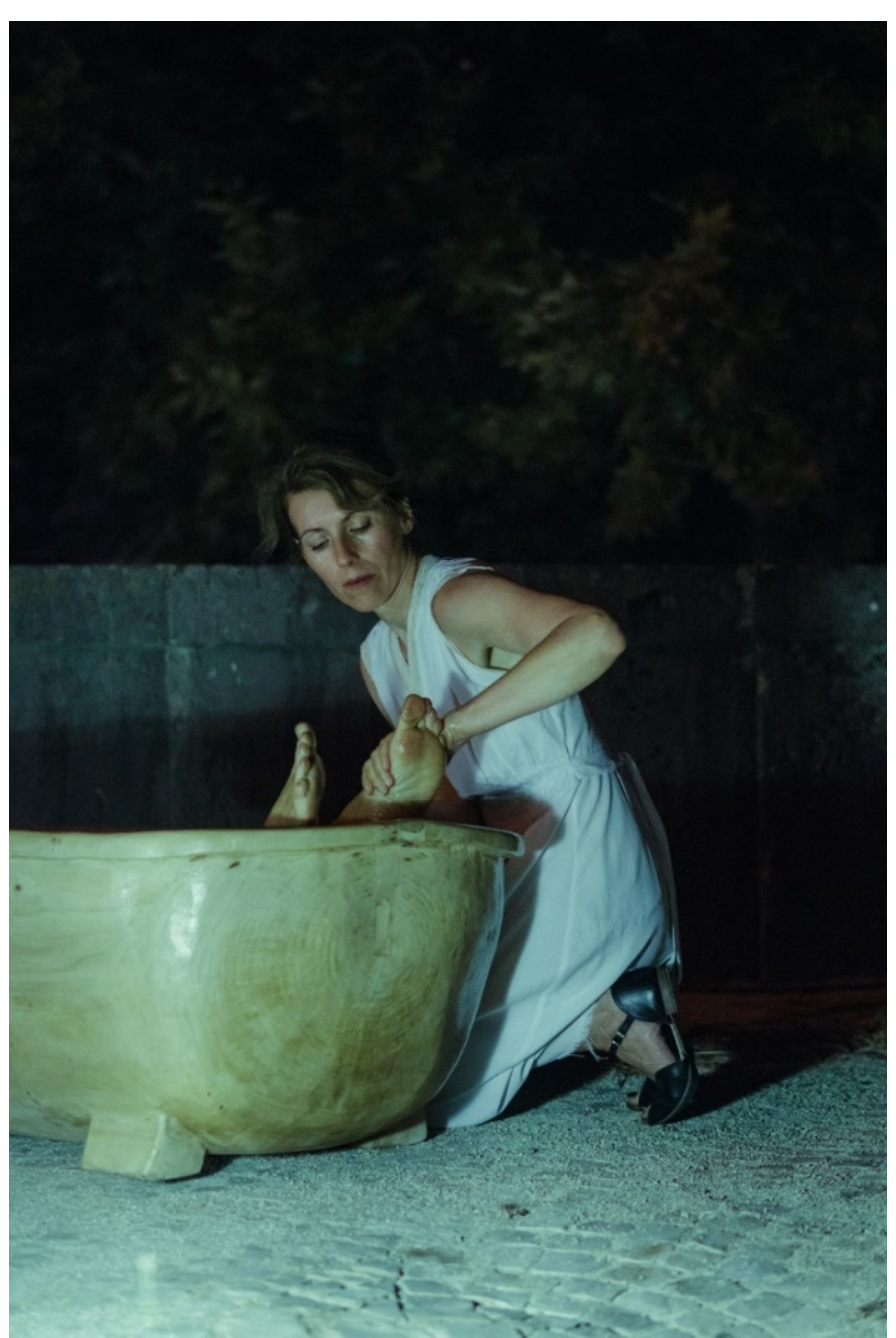
Figure 6. Place of Bath . Feet massage in a bathtub by performer Célia Fechas. Mãe d’Água das Amoreiras Reservoir, Lisbon, 2019. © Joana Linda.